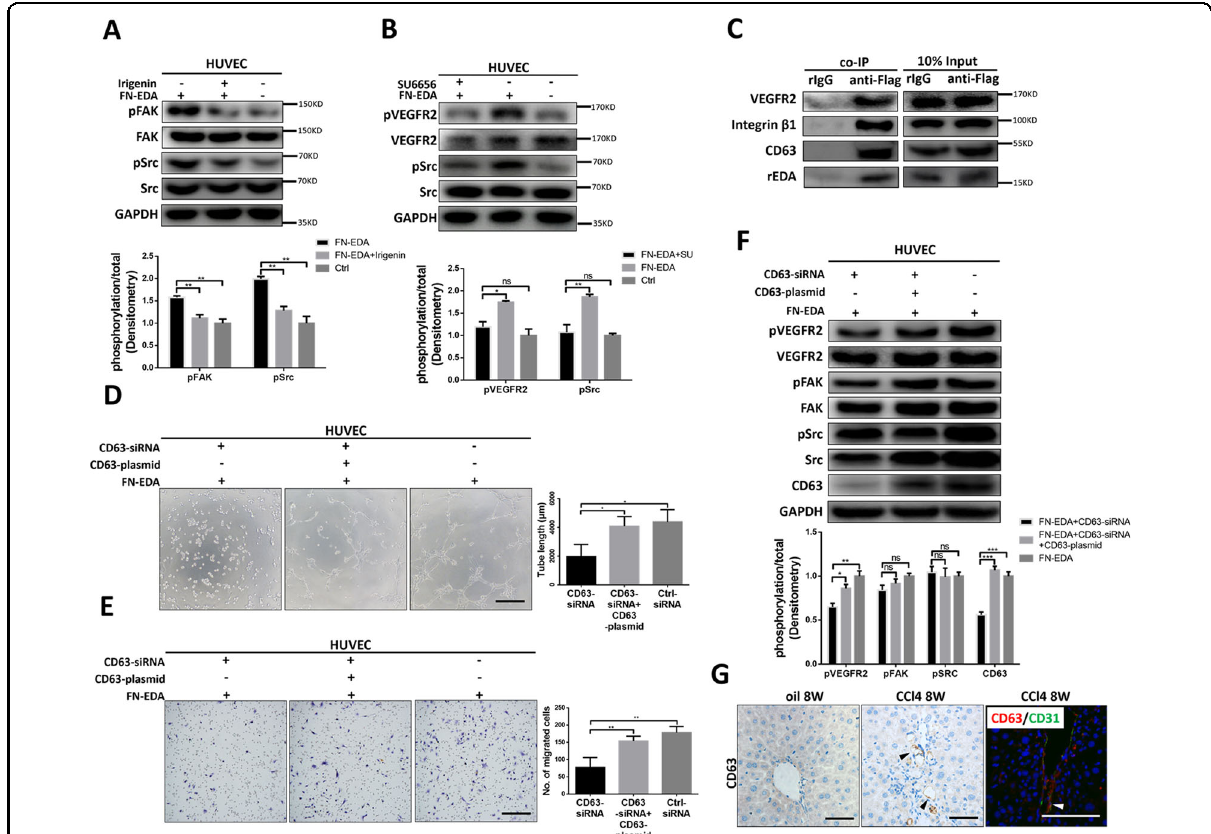
Fig. 5 CD63 participated in FN-EDA induced angiogenesis. A Immunoblot result of HUVECs treated with FN-EDA and/or irigenin for 6 h. (Data are shown as mean ± SEM; pFAK: FN-EDA versus Irigenin + FN-EDA: ** P < 0.001, FN-EDA versus Ctrl: ** P < 0.001; pSrc: FN-EDA versus Irigenin + FN-EDA: ** P < 0.001, FN-EDA versus Ctrl: **P < 0.001.) B Immunoblot result of HUVECs treated with FN-EDA and/or Src inhibitor SU6656 for 6 h. (Data are shown as mean ± SEM; pVEGFR2: FN-EDA + SU6656 versus FN-EDA: * P < 0.01; pSrc: FN-EDA versus Ctrl: ns; pSrc: FN-EDA + SU6656 versus